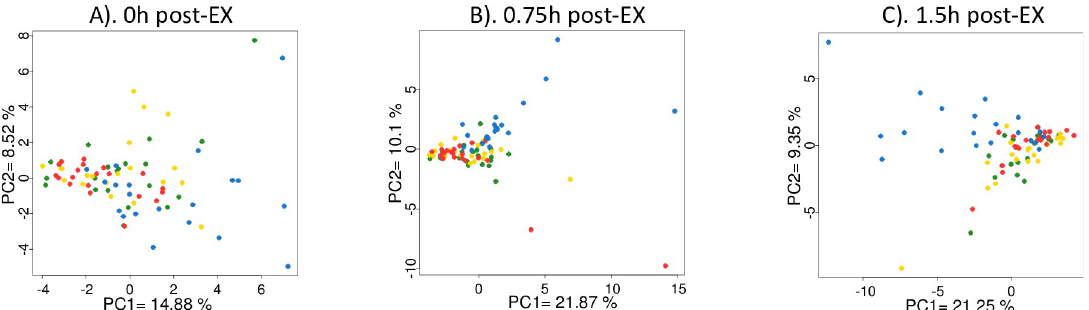
Fig 2. PCA analysis of data during the first 1.5 h recovery from 75-km cycling. A). Immediately post-exercise; B). 0.75 h post-exercise; C). 1.5 h post-exercise. The data support a distinct difference between the water trial and the three carbohydrate-based trials. Blue = water trial; Red = sugar beverage trial; Green = Cavendish banana trial; Yellow = Mini-yellow banana trial.